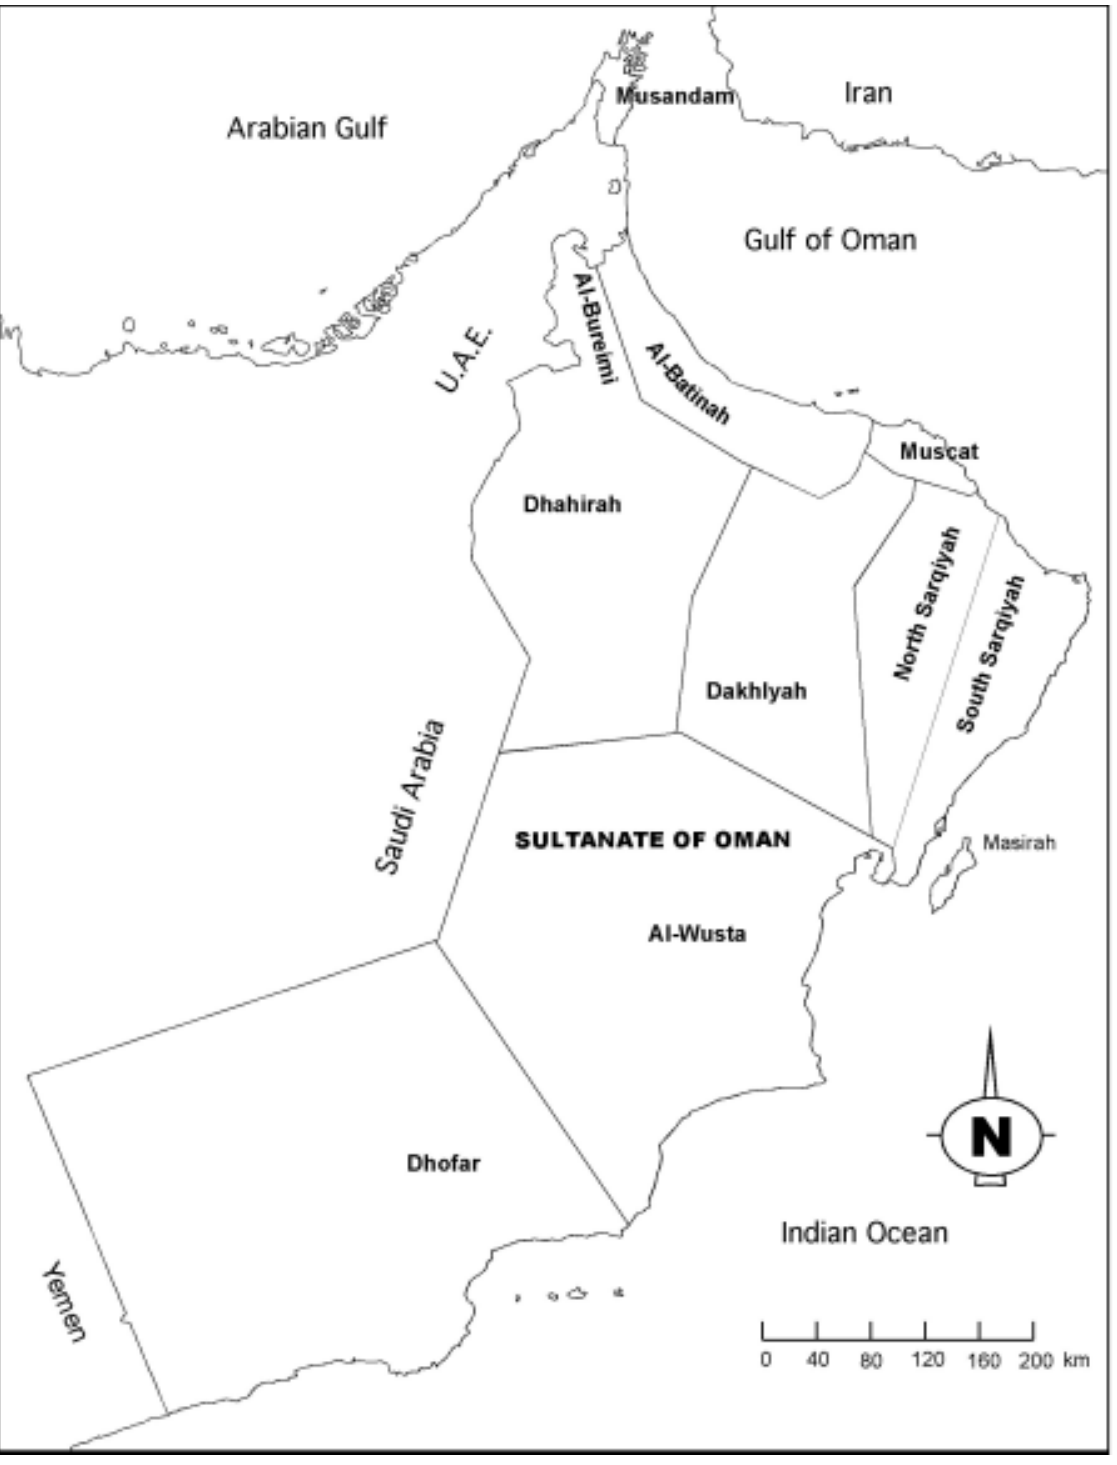
Fig. 1. Map of the Sultanate of Oman showing the regions in which leafhoppers were collected from alfalfa